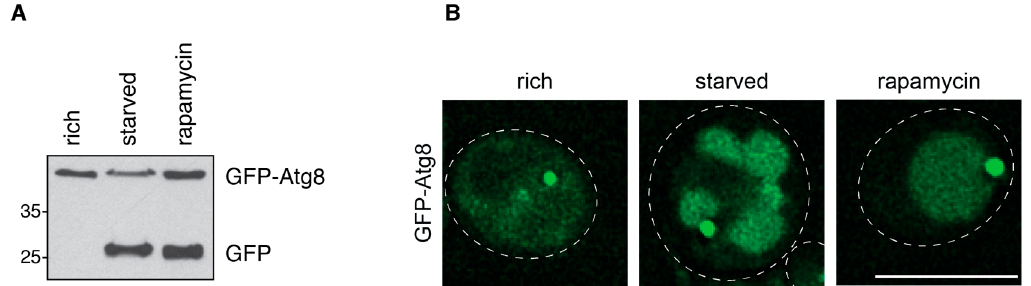
Figure 3. GFP-Atg8 assays to assess bulk autophagic activity. ( A ) Vacuolar delivery of GFP-Atg8 by bulk autophagy assessed by Western blotting using an anti-GFP antibody. The GFP moiety is resistant to vacuolar hydrolases, while Atg8 is degraded. This leads to the appearance of a free GFP band. Cells were grown to mid-log phase overnight (rich) and then nitrogen-starved or rapamycin-treated for six hours. Samples were prepared by TCA (trichloroacetic acid) precipitation; ( B ) Vacuolar delivery of GFP-Atg8 by bulk autophagy visualized by fluorescence microscopy. Cells were grown to mid-log phase overnight (rich) and then nitrogen-starved or rapamycin-treated for six hours. Vacuoles are stained intensely with GFP after starvation and treatment with rapamycin. Note that during starvation, but not during rapamycin treatment, vacuoles appear fragmented in BY474x strains. Due to the upregulation of Atg8 expression during bulk autophagy induction, contrast was adjusted individually for the “rich” image. Dashed lines: cell outlines. Scale bar: 5 µm.